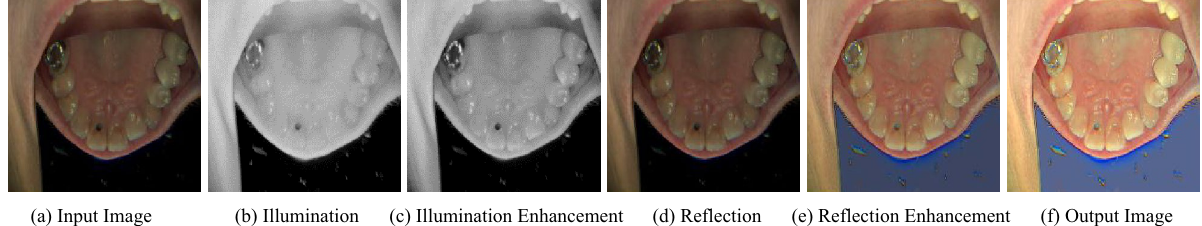
Figure 2. The decomposition of the input into reflection and illumination with respective enhancement